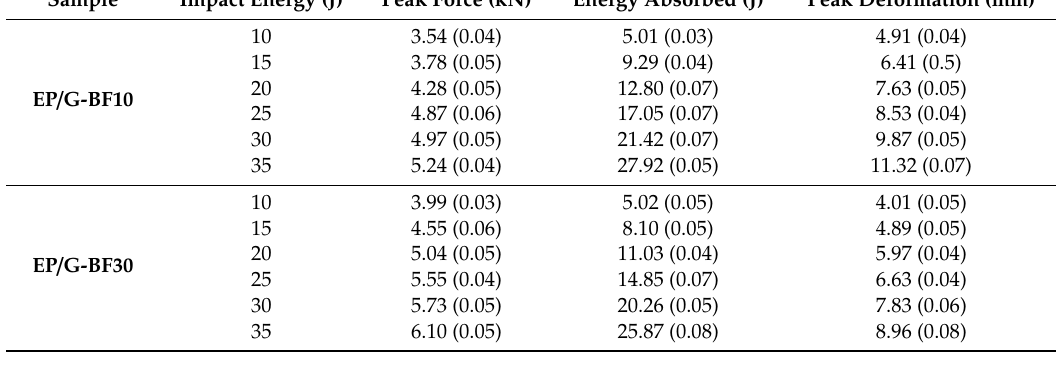
Table 4. Data analysed from the force displacement graphs of EP/G-BF10 and EP/G-BF30 at the second range of the impact energy level.